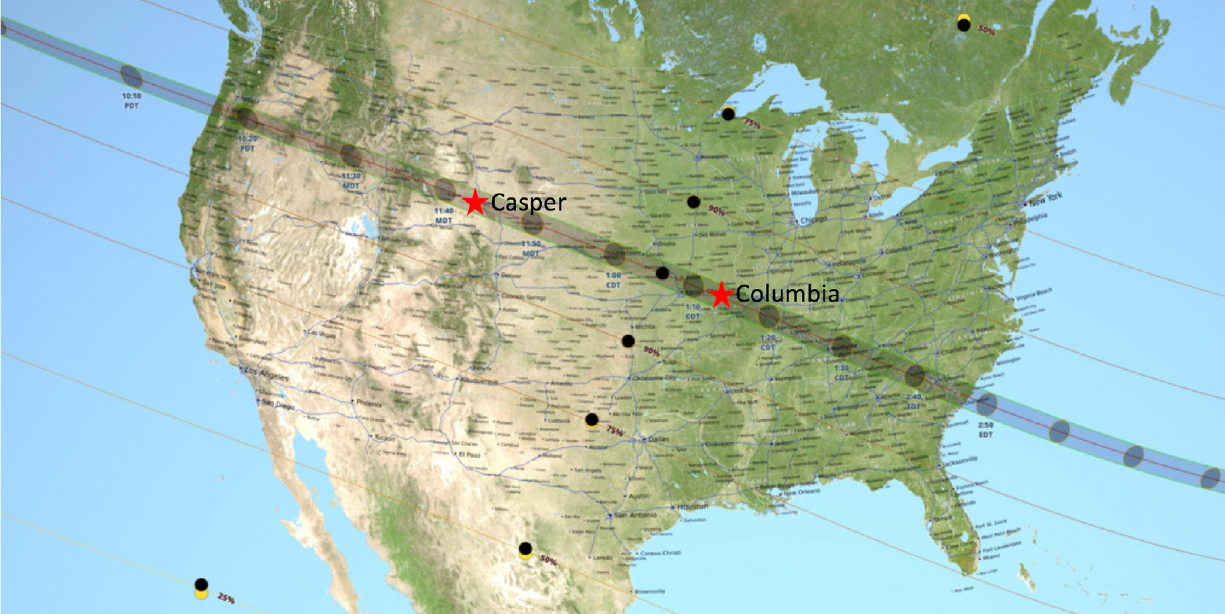
Figure 1. The eclipse map (from https://eclipse2017.nasa.gov, last access: 21 August 2020) shows the totality path and obscuration levels on 21 August 2017. Radiometers were deployed to make ground-based observations at Casper, Wyoming, and Columbia, Missouri. Table 1. Parameters for the 21 August 2017 eclipse for Casper, Wyoming, and Columbia, Missouri. The first contact (C1), the moment when the Moon first touches the Sun’s disk or the beginning of the partial eclipse; the second contact (C2), the beginning of totality; the maximum of the totality (Max); the third contact (C3), the end of totality; the fourth contact (C4), the instant when the Moon just leaves the Sun’s disk or the end of the partial eclipse. The elevation of the site (Elev.) and solar zenith angle (SZA) and solar azimuth angle (SAA) at the totality are